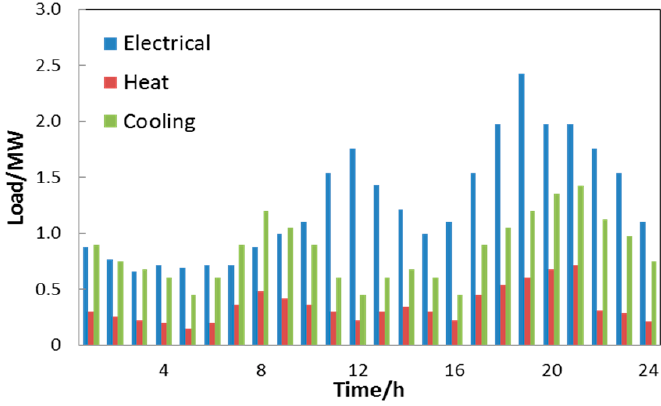
Figure 6. Electrical, heat, and cooling demand in a sample day.